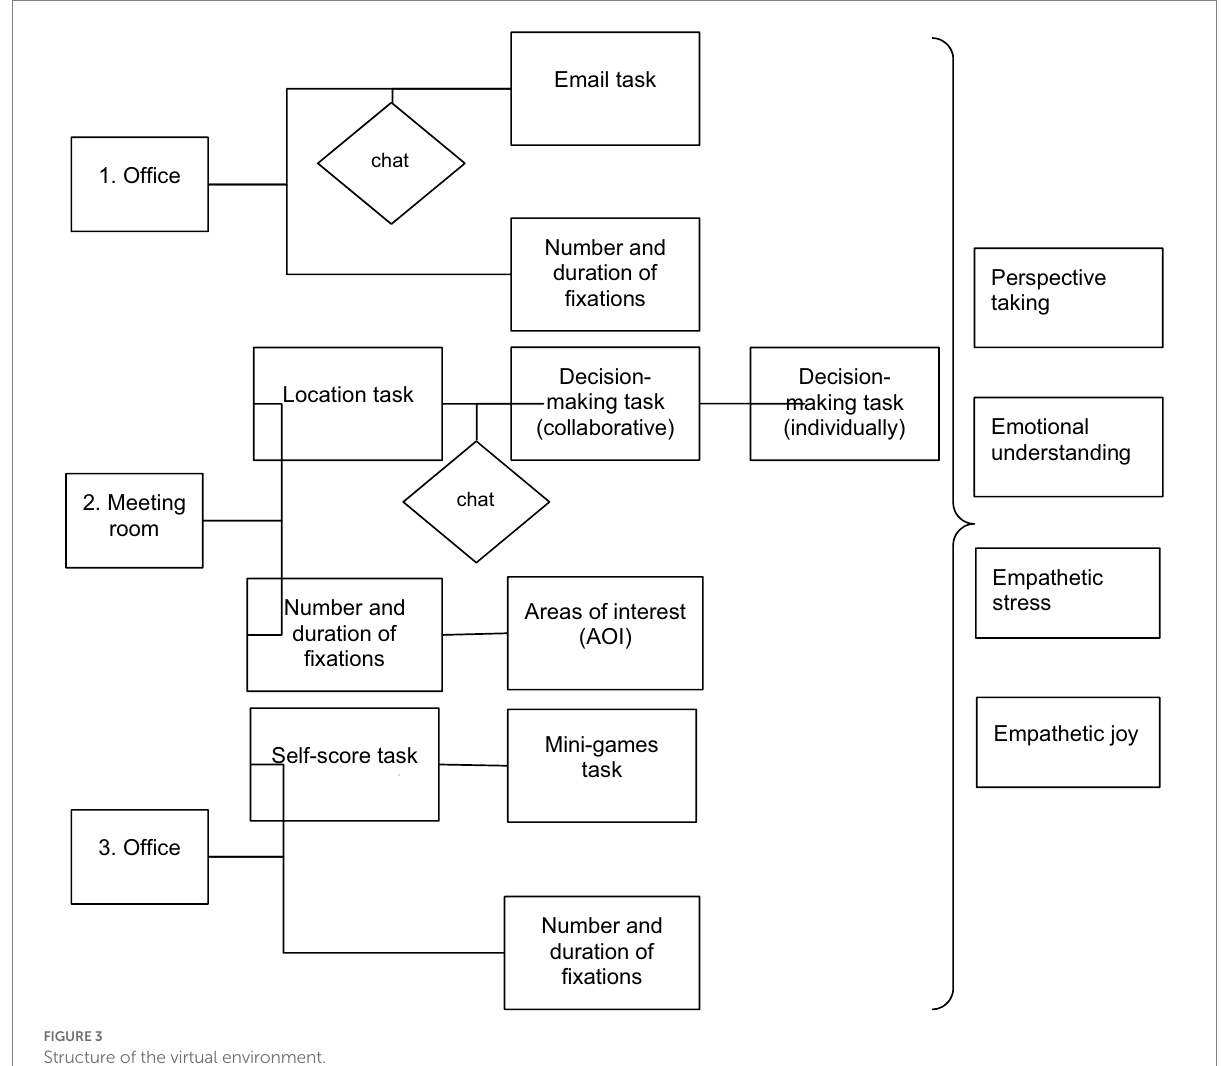
FIGURE 3 Structure of the virtual